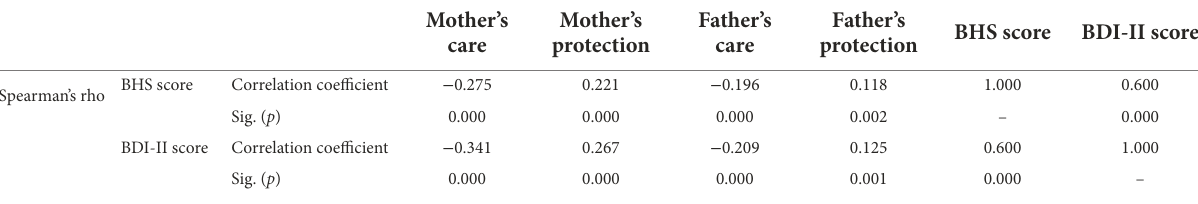
TABLE 4 Nonparametric correlations between father’s and mother’s “care” and “protection” and BHS and BDI-II